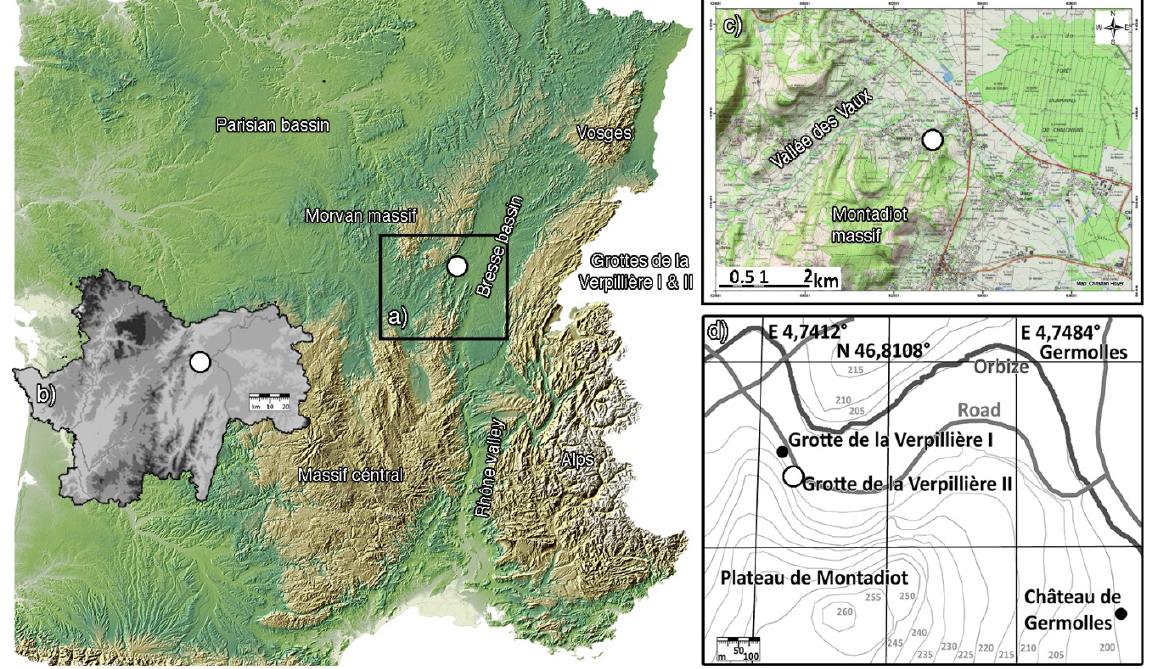
Figure 1. Location of Grotte de la Verpillière II (white point with black fringe). a) Position of Sâone-et-Loire department on a relief map of South-east France (NASA, SRTM 2000, www.pacha-cartographie.com); b) Relief map of Sâone-et-Loire department (NASA, SRTM 2000 from S.R.A Bourgogne); c) Logistic area around VP II on a topographical map (25k TOP map, Beaune-Chagny from the Institut géographique national , IGN 2005, GIS: Ch. Hoyer) and d) Immediate surrounding of VP II (Redrawn from 25k TOP map, Beaune-Chagny from the Institut géographique national , IGN 2005 and GoogleEarth map from